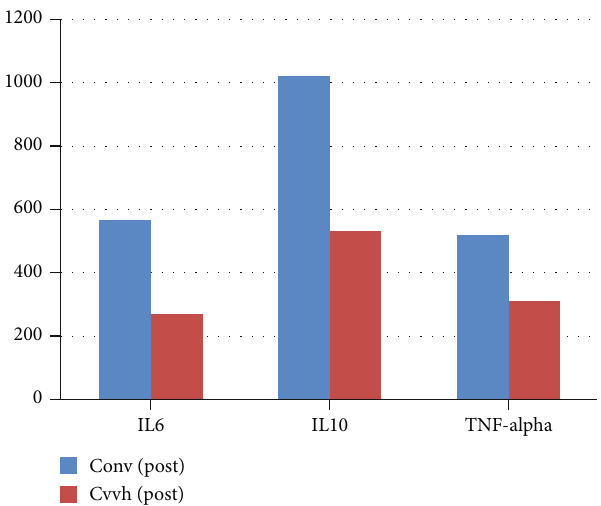
Figure 2: Bar chart: posttreatment IL-6, IL-10, and TNF-alpha in both groups; their di ff erence was statistically signi fi cant ( p < 0 : 01